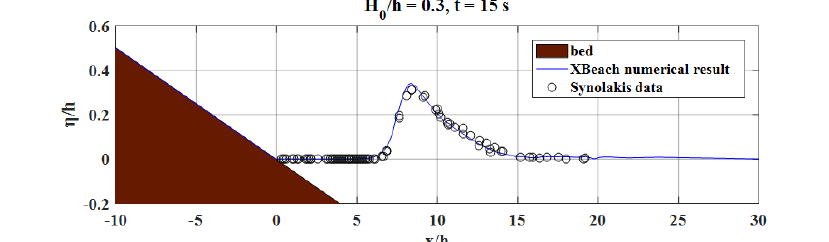
Figure 3. Runup of a solitary wave on a beach: snapshot of free-surface profile at t = 15 s. Line: numerical results by XBeach [20]. Symbol: experimental data by Synolakis [26]. The initial wave nonlinearity is 0.3, the constant depth is 0.1 m, and the beach slope is